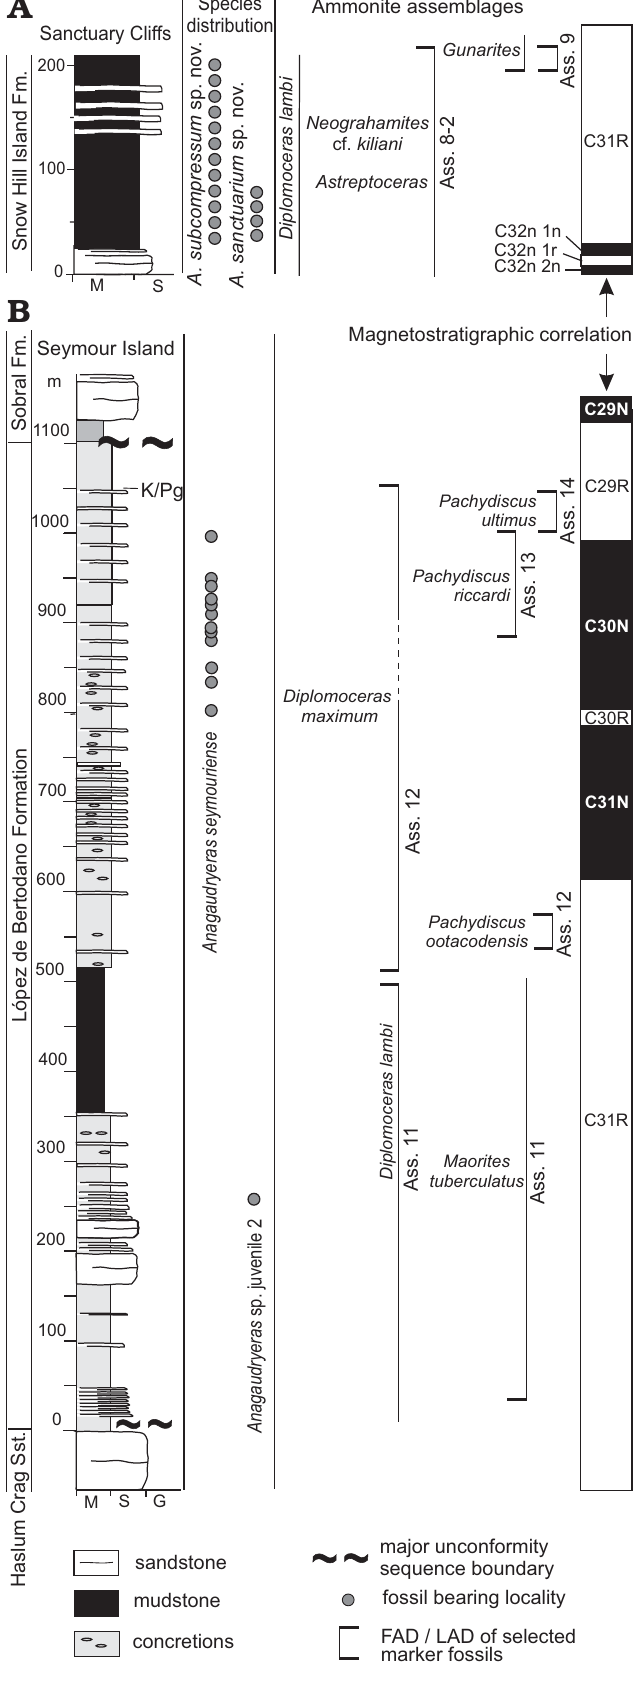
fig. 2 (Plot of U against D), of Anagaudryceras cf. A. politis-